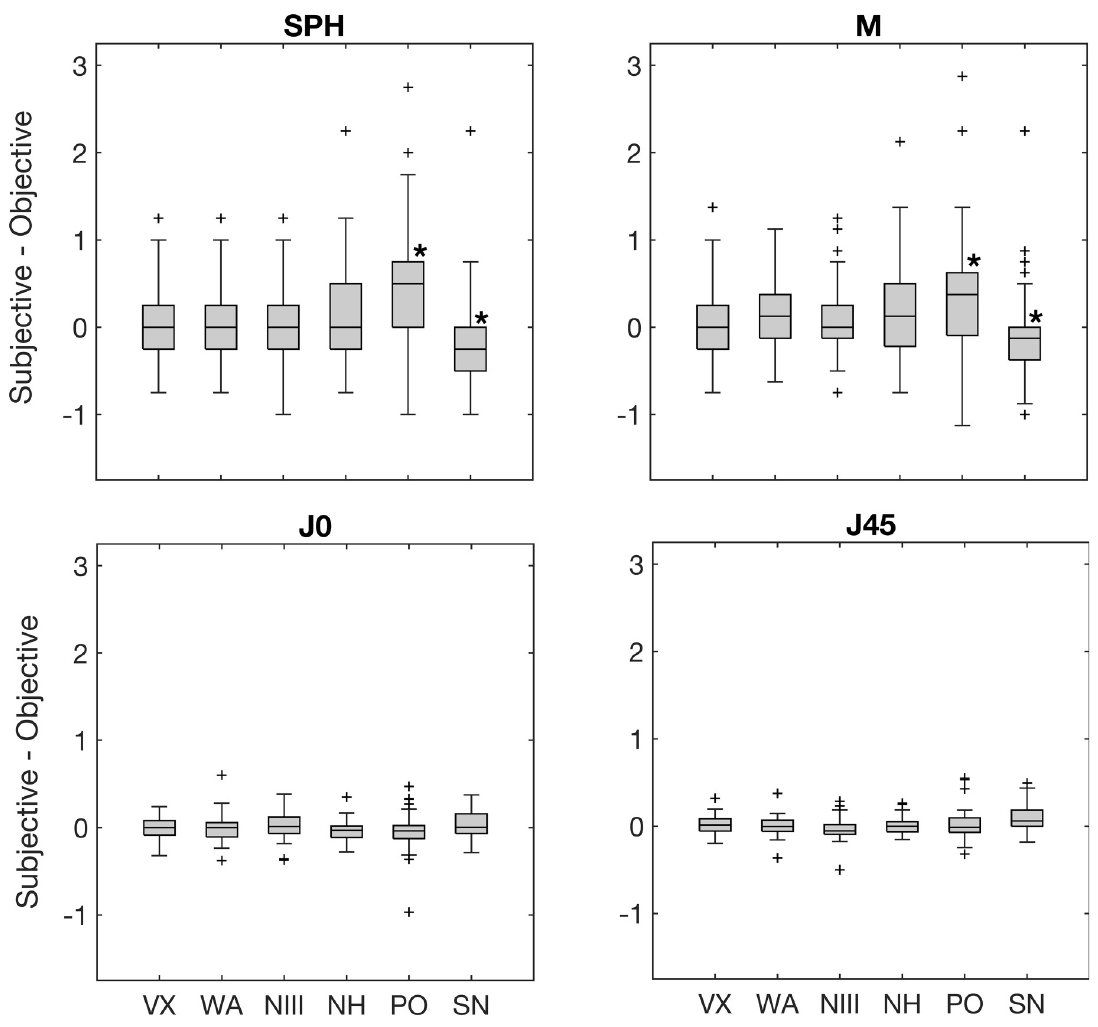
Fig 2. Average differences between subjective refraction and objective refraction for sphere, spherical equivalent and the cylindrical vector components. The asterisks ( � ) indicate statistically significant differences. The error bars represent the standard deviation of the differences. Check Fig 1 captions for